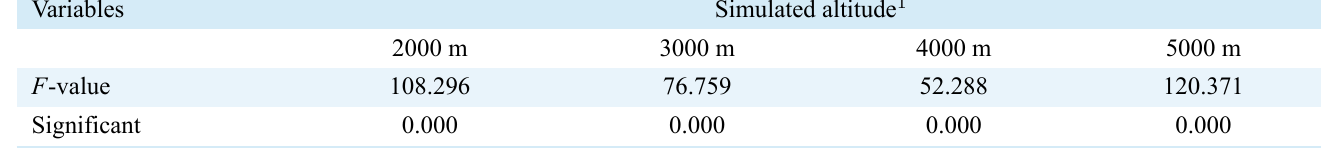
TABLE 9. F -test and significance values for each regression